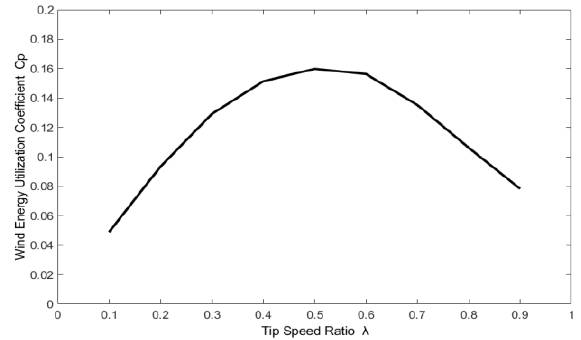
Figure 14. Tip speed ratio–wind energy utilization coefficient curve.